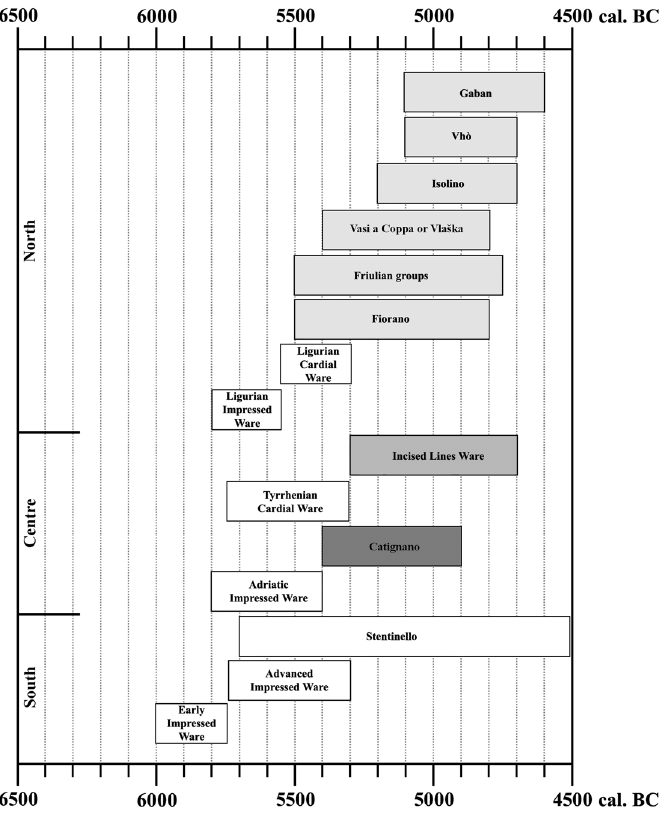
Figure 1: Chronological chart of Early Neolithic groups in Italy ( after Biagi & Starnini, 2016; Biagi et al., 2020; Improta & Pessina, 1998; Natali & Forgia, 2018; Pessina & Tiné, 2008; Radi & Petrinelli Pannocchia, 2018; Starnini et al., 2018; Tiné, 2002 )